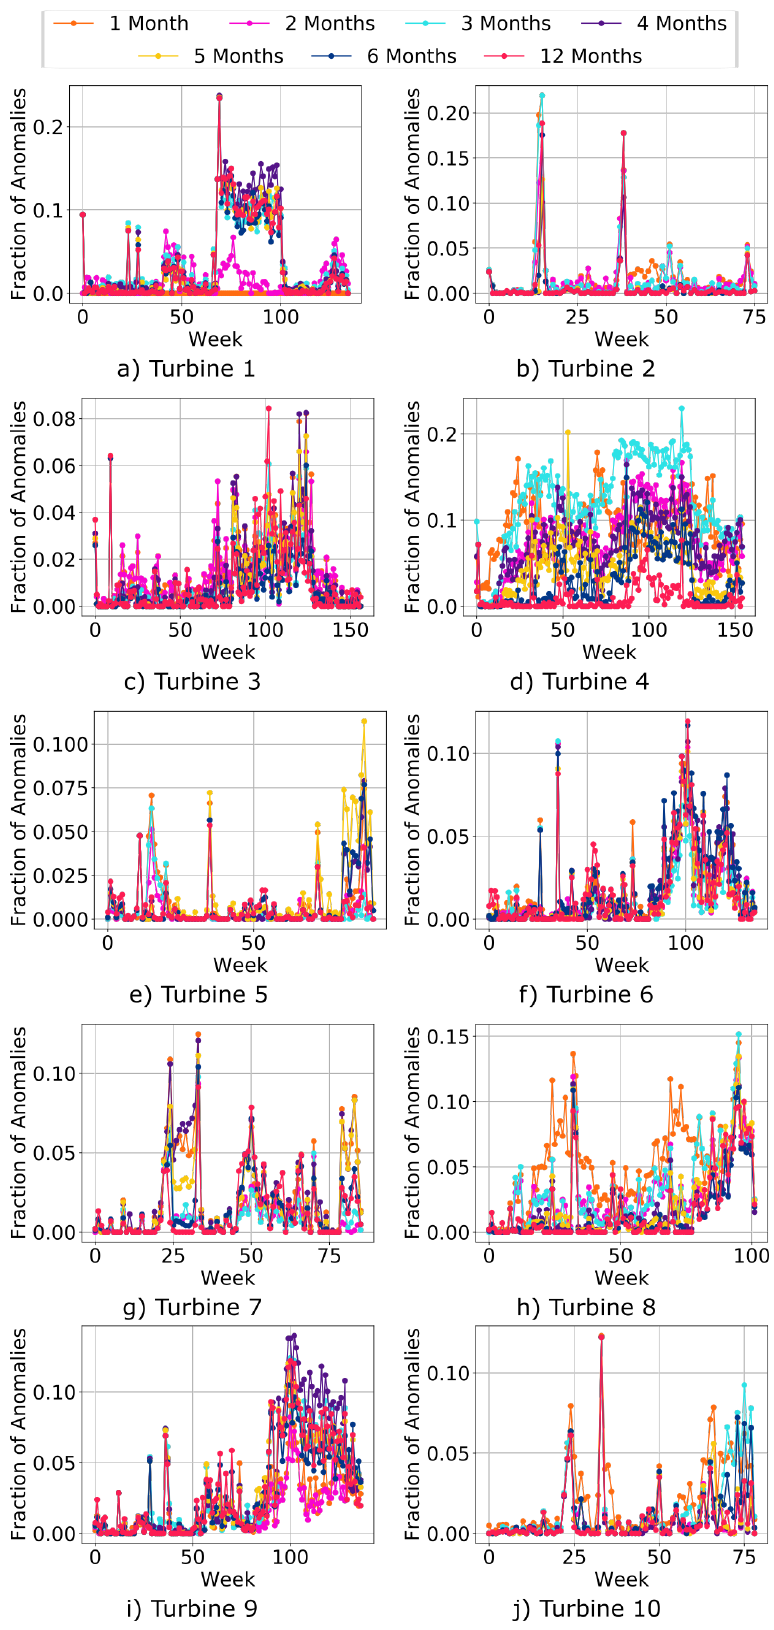
Figure 4. Weekly Anomaly proportions for Case Study 1 with Feedback